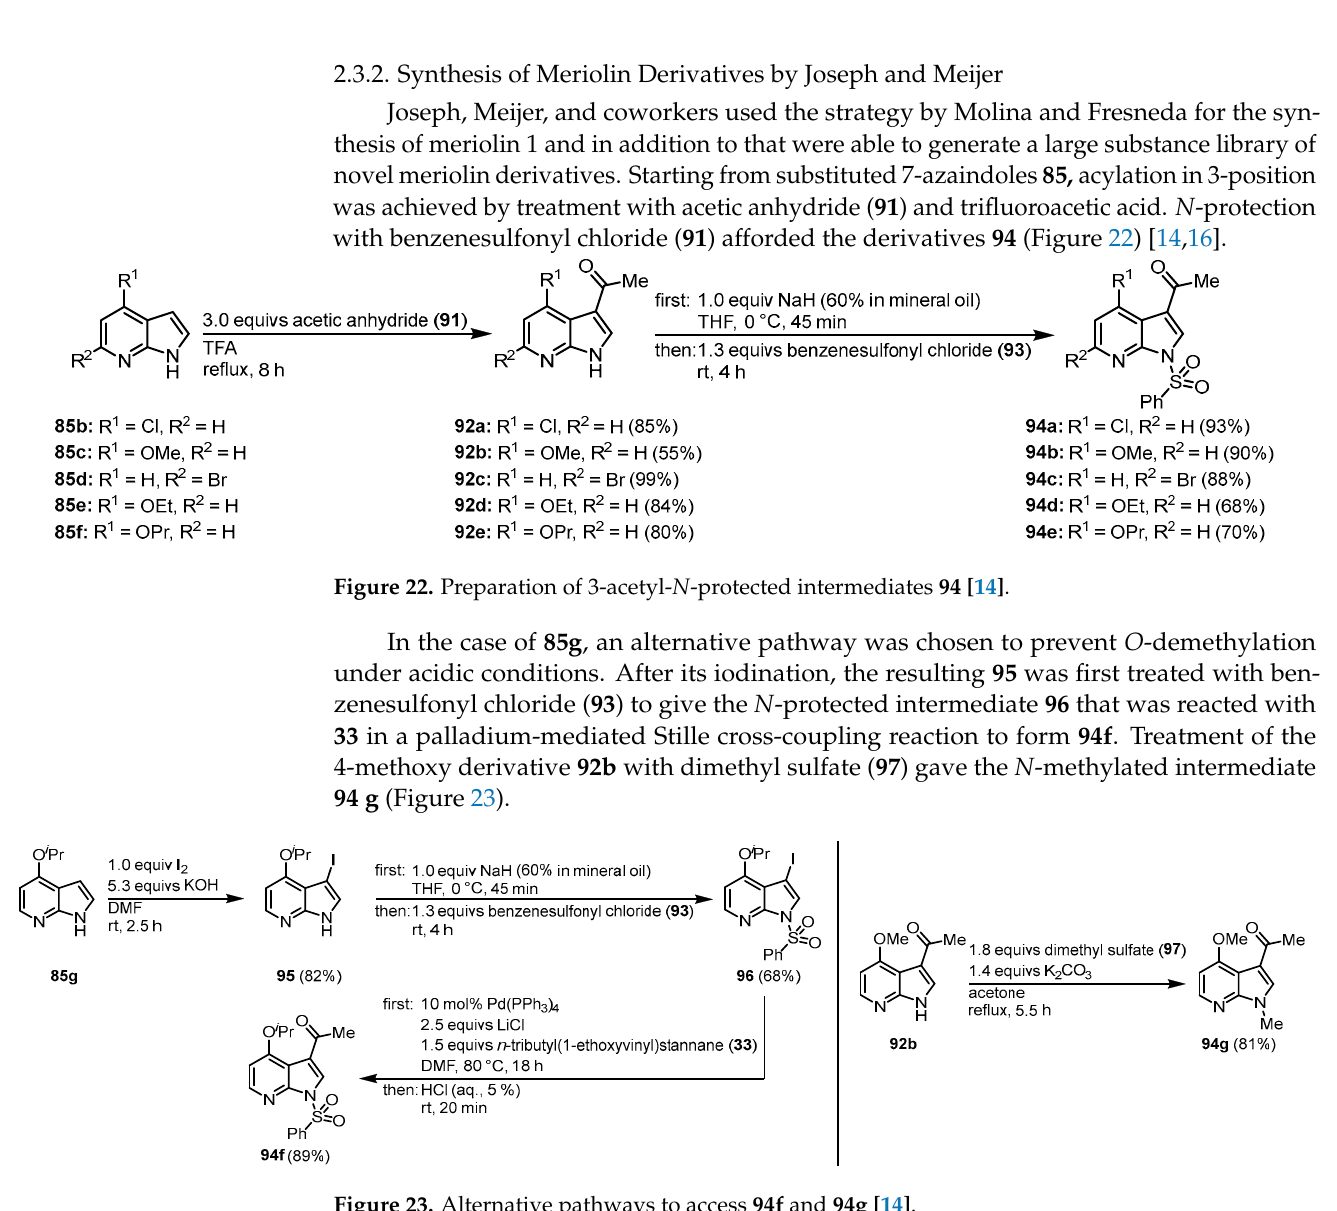
Figure 21. Synthesis of meriolin 1 by Molina and Fresneda [15].